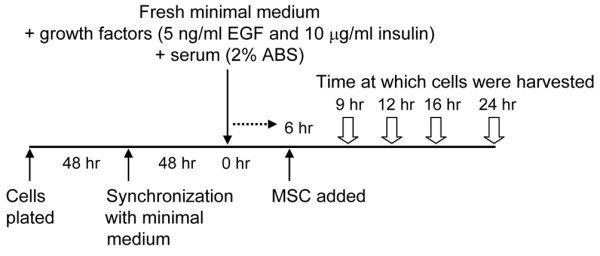
General scheme for synchronization and treatment of TM6 cells with Se-methylselenocysteine (MSC) including the collection times. The TM6 cells were plated at a density of 6.6 × 103 cells/cm2 in either 100 mm dishes or six-well plates. After 48 hours of growth the cells were starved in DMEM/F12 medium without growth factors and serum (minimal medium) for a further 48 hours. The cells were released from starvation with DMEM/F12 medium containing growth factors (5 ng/ml epidermal growth factor (EGF) and 10 μg/ml insulin) and serum (2% adult bovine serum). After a further 6 hours MSC was added at a final concentration of 50 to 400 μM (depending upon the experiment) to one set of cells. Untreated cells served as controls. The cells were collected after starvation (0 hours), then at 6 (before the addition of MSC), 9, 12, 16 and 24 hours time-points.